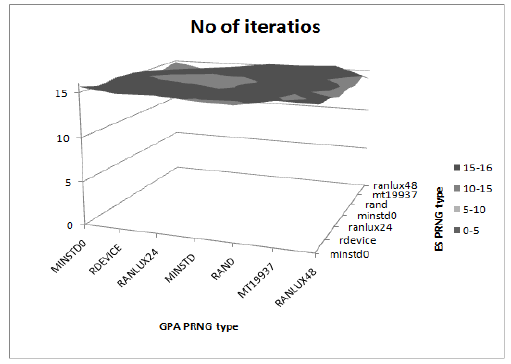
Fig. 2: Average number of iterations of GPA-ES algo- rithm depending on PRGNs in(cid:29)uencing GPA and ES part of the